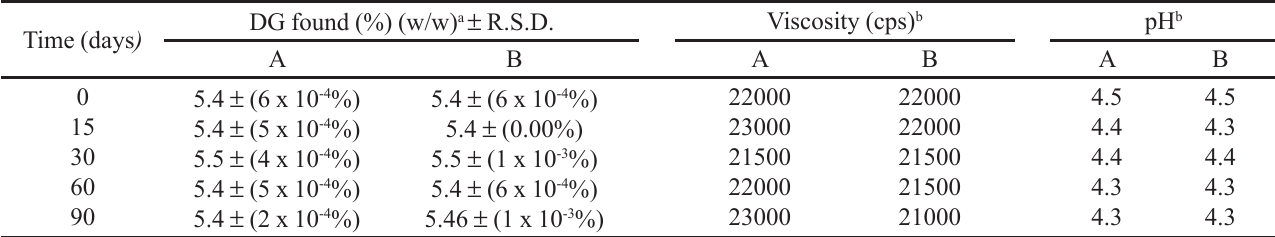
TABLE VI - Results of stability studies for DG assay and pH verified in stored (A) room samples and (B) accelerated conditions using PT